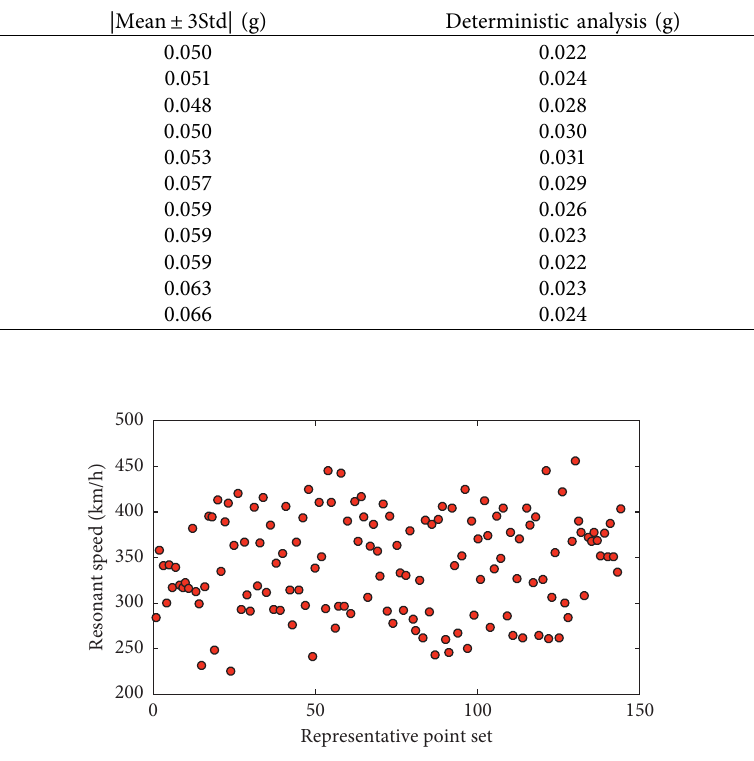
Figure 12: Random resonant speeds based on the representative point sets of the TSB